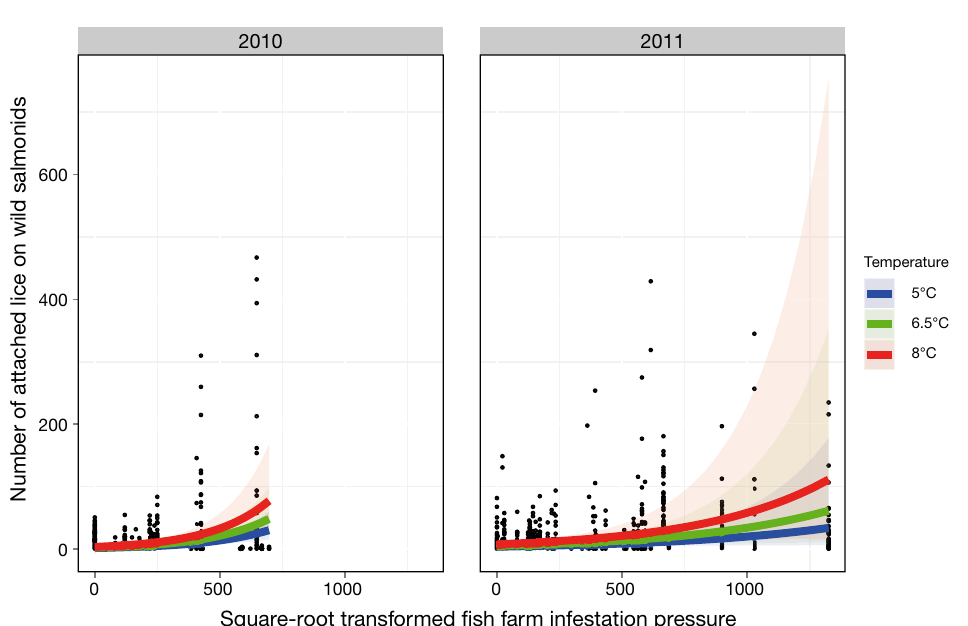
Fig. 3. Fitted values (with 95% CI) from the zero-truncated negative binomial generalized linear mixed model showing pre- dicted attached lice counts on wild salmonids as a function of the lice infestation pressure imposed by nearby farms (<30 km) for 3 different temperature values. Fish farm pressure is expressed as the total number of female lice on nearby farms, linearly corrected by distance as explained in Serra-Llinares et al. (2014). Black dots show actual observed number of attached